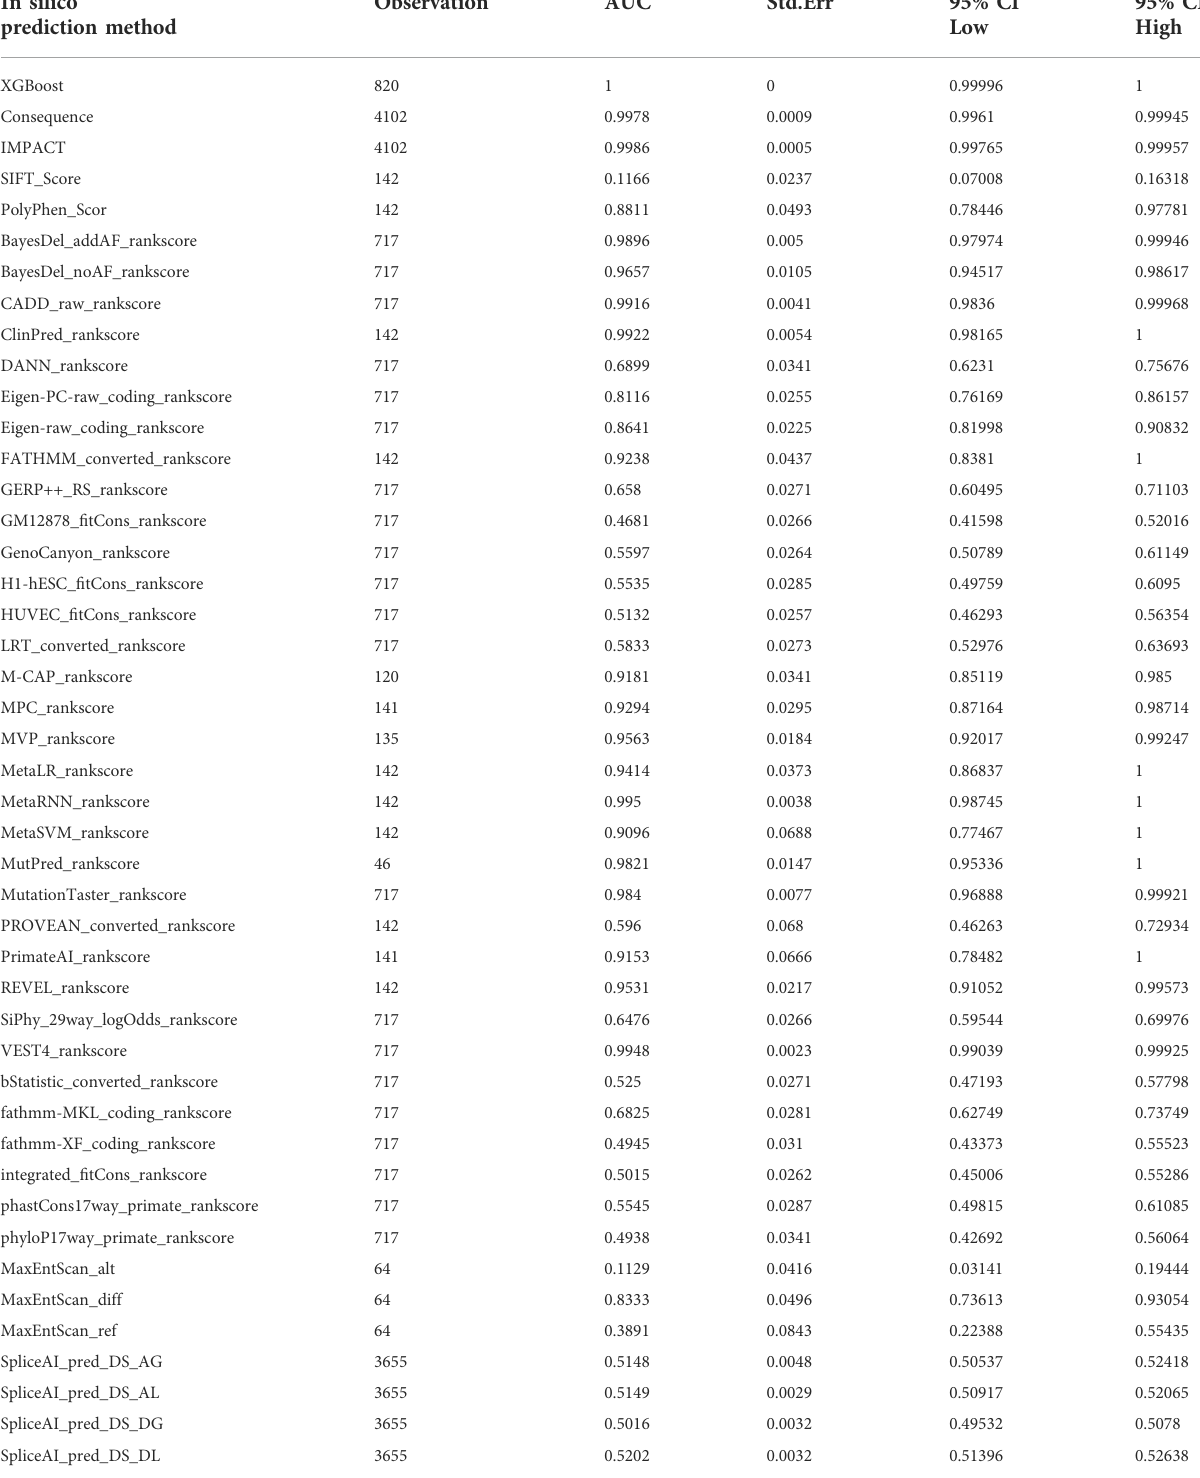
TABLE 1 The receiver operating characteristic (ROC) curve analysis for the different in silico predictions. AUC: Area under the curve, Obs: Number of observations, Std.Err: Standard error, CI: Con fi dence interval. In silico Observation AUC Std.Err 95% CI prediction method